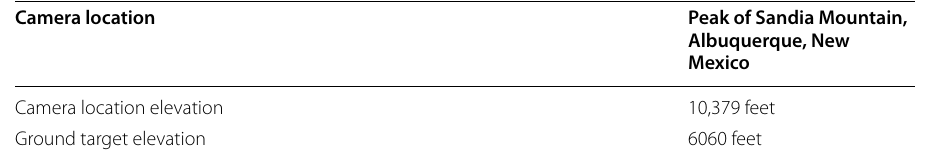
Table 2 Experiment